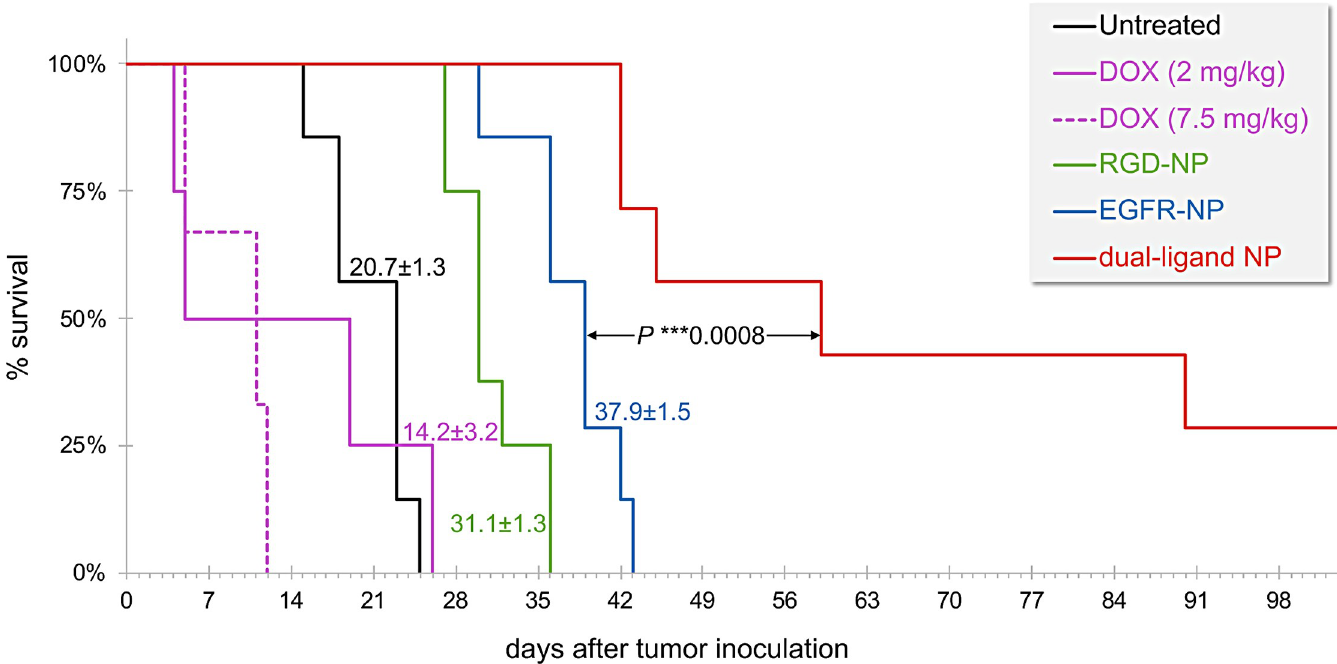
Fig 4. The survival time of metastasis-bearing mice treated with cytotoxic drugs was compared to untreated animals. The animals were treated at days 3, 4 and 5. The dual-ligand nanoparticle formulation was administered at 7.5 mg/kg DOX. In addition to the nanoparticle formulation, treatments included free DOX injected at 7.5 or 2.5 mg/kg (n = 6–8 mice per treatment). The difference between the survival curves of the dual-ligand NP and EGFR-NP-treated groups was assessed by the log- rank (Mantel-Cox) test.